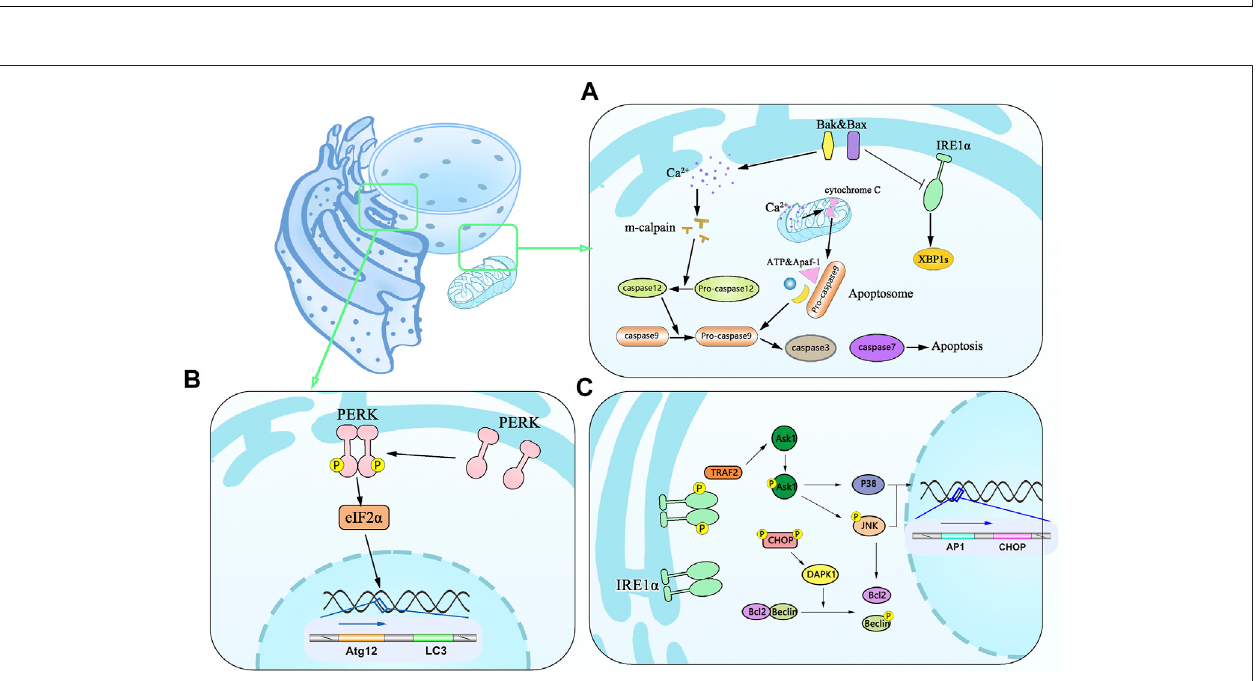
FIGURE3| SchematicdiagramofapoptosisassociatedwiththemitochondrialpathwayandautophagyinducedbyERstress. (A) EffectorproteinsofBaxandBak in apoptosis undergo conformational changes in active forms and oligomerize in the ER membrane leading to the ef fl ux of Ca2+ from the ER to the cytoplasm and activating m-calpain to cleave and activate procaspase-12, which in turn activates caspase-3 and caspase-7. BAX and BAK are associated with the decreased expression of IRE1 and XBP1 and promote apoptosis. Ca 2+ can be taken up by mitochondria leading to depolarization of the mitochondrial inner membrane and cytochrome c release, which binds Apaf-1, procaspase-9, and ATP into apoptosome and activates caspase-9 and caspase-3, then resulting in cell death. (B) Dimmerized PERK phosphorylates the translation initiation factor eIF2 α and mediates the translation of Atg12 and LC3. (C) Activated IRE1 forms P-IRE1 α /TRAF2 complex and initiates Ask1 as a stress-responsive in the JNK and p38 pathways. Phosphorylated JNK along with activated P38 enters the nucleus to promote translation of AP1 and CHOP.